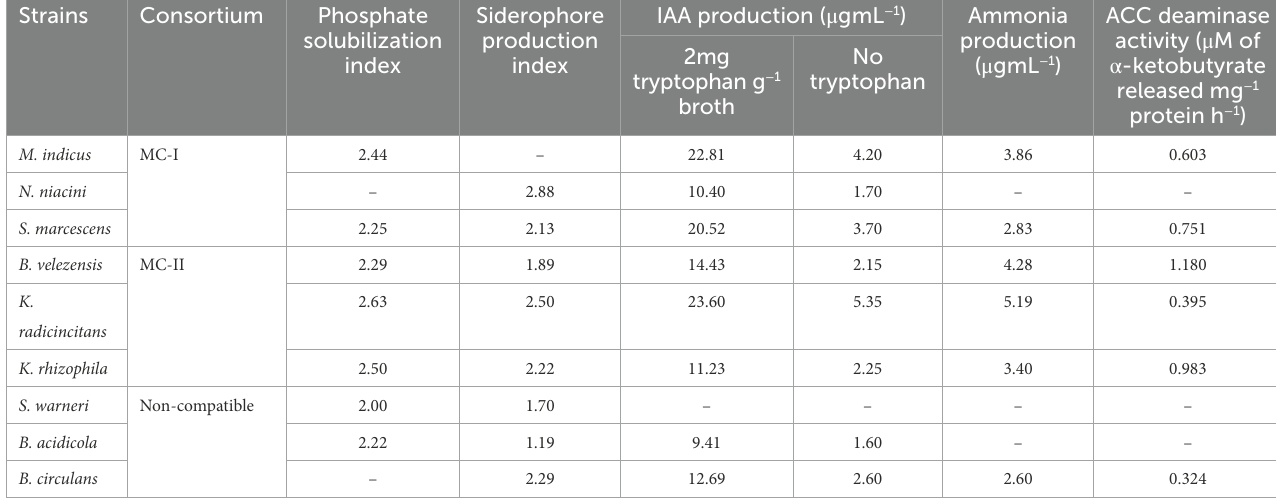
TABLE 3 Plant growth promotion capabilities of the bacterial isolates from the rhizosphere and endosphere of S. portulacastrum .